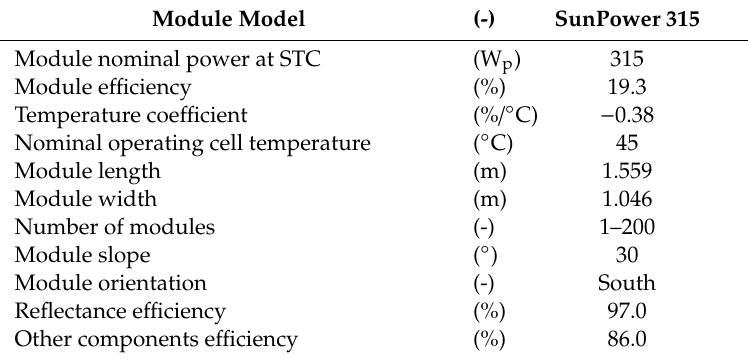
Table 2. Photovoltaic system